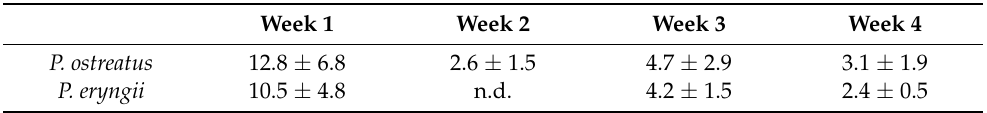
Table 2. MnP (U kg − 1 ) activity in TCE-polluted soil with mycoremediation using P. ostreatus and P. eryngii . Data present the mean ± standard deviation of three replicates.